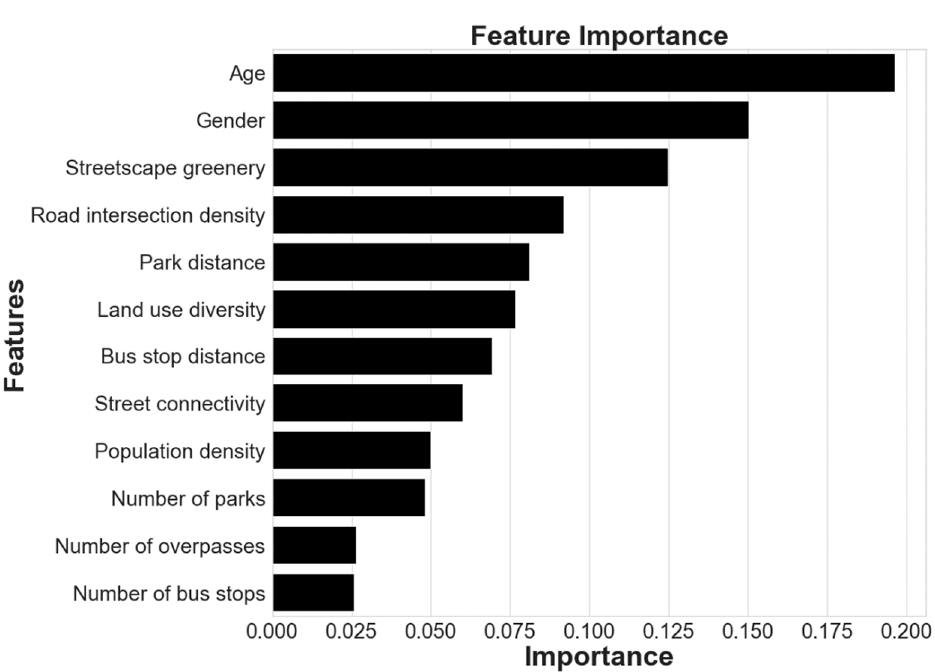
Figure 3. Predictor variables’ relative relevance.